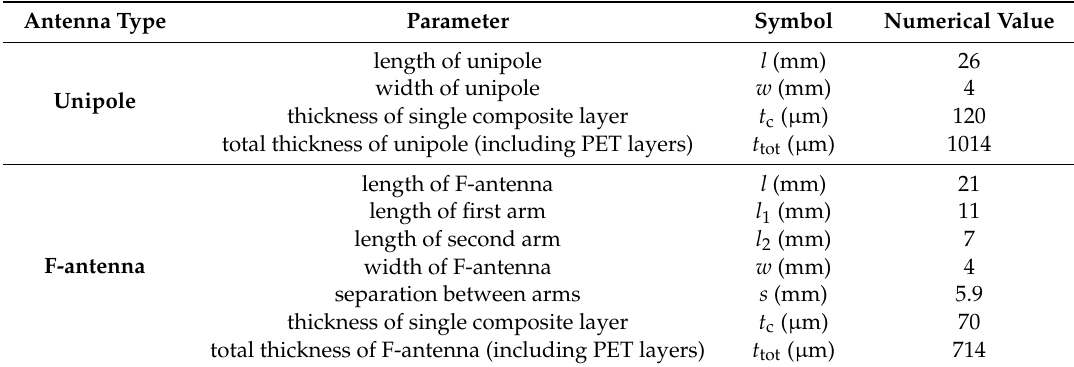
Figure 14. 3D model of unipole and F-antenna in CST microwave studio. Table 1. Physical dimensions of the unipole and the F-antenna.